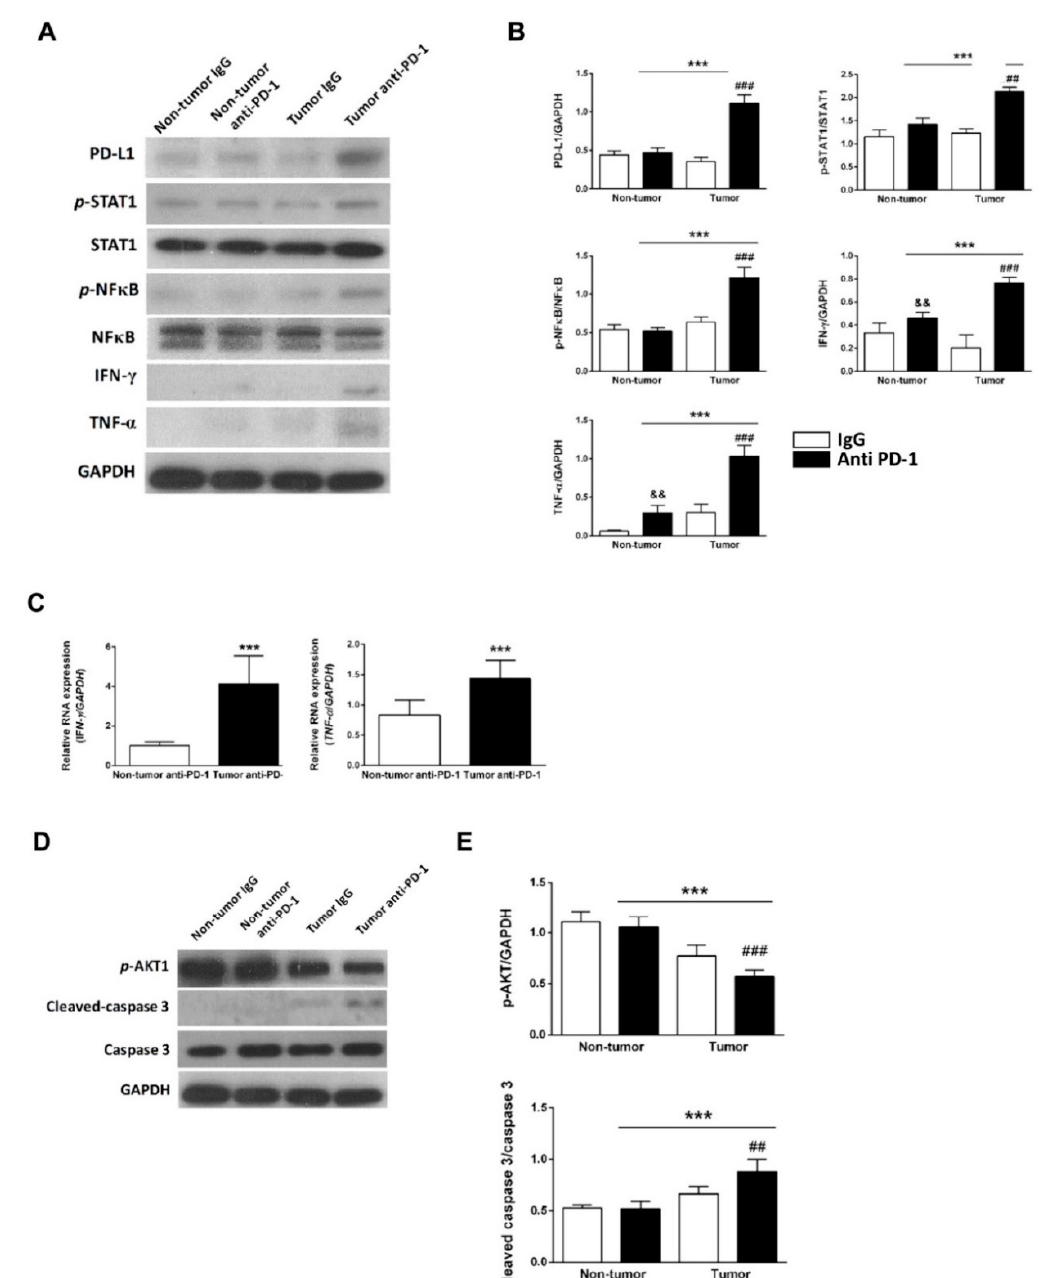
Figure 5. E ff ects of anti-PD-1 immunotherapy on the expression of PD-L1 and inflammation-related markers in tumor-bearing mice. ( A ) Representative western blot analysis and quantitative results ( B ). && p < 0.01, ### p < 0.001 versus rat IgG-treated tumor group; *** p < 0.001 versus anti-PD-1-treated non-tumor group; && p < 0.01 versus rat IgG-treated non-tumor group ( n = 4), two-way ANOVA, posthoc Bonferroni test. ( C ) A representative of RT-PCR analysis of IFN- γ and TNF- α in the anti-PD-1-treated non-tumor group and anti-PD-1-treated tumor group. *** p < 0.001 versus anti-PD-1-treated non-tumor group ( n = 4), unpaired Student’s t-test. Data are shown as the mean ± SD. ( D ) Representative western blot analysis of apoptosis markers and quantitative results ( E ). ## p < 0.01, ### p < 0.001 versus rat IgG-treated tumor group; *** p < 0.001 versus anti-PD-1-treated non-tumor group ( n = 4), two-way ANOVA, posthoc Bonferroni